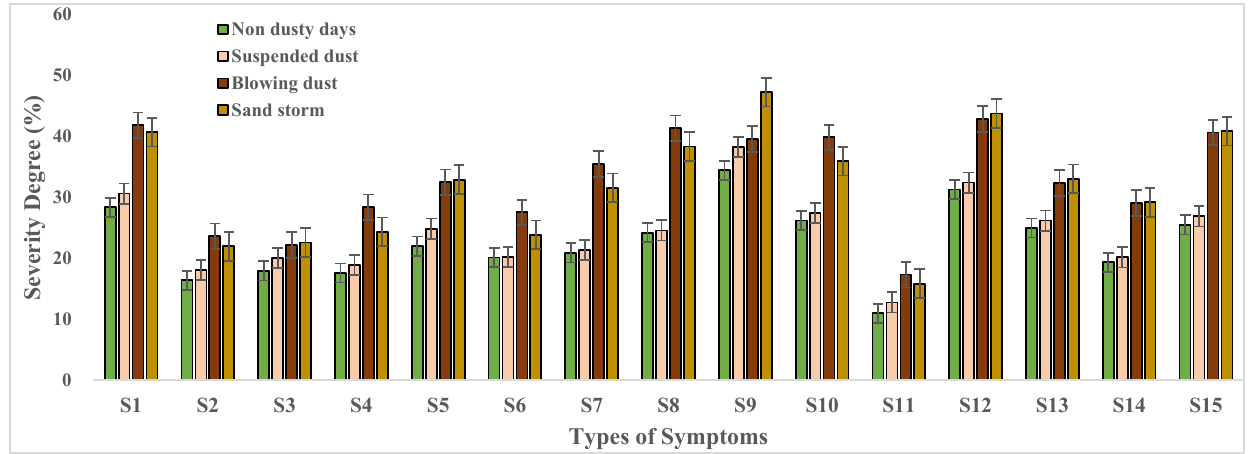
Figure 3. The severity of different health symptoms in different dusty weather conditions. Note: S 1